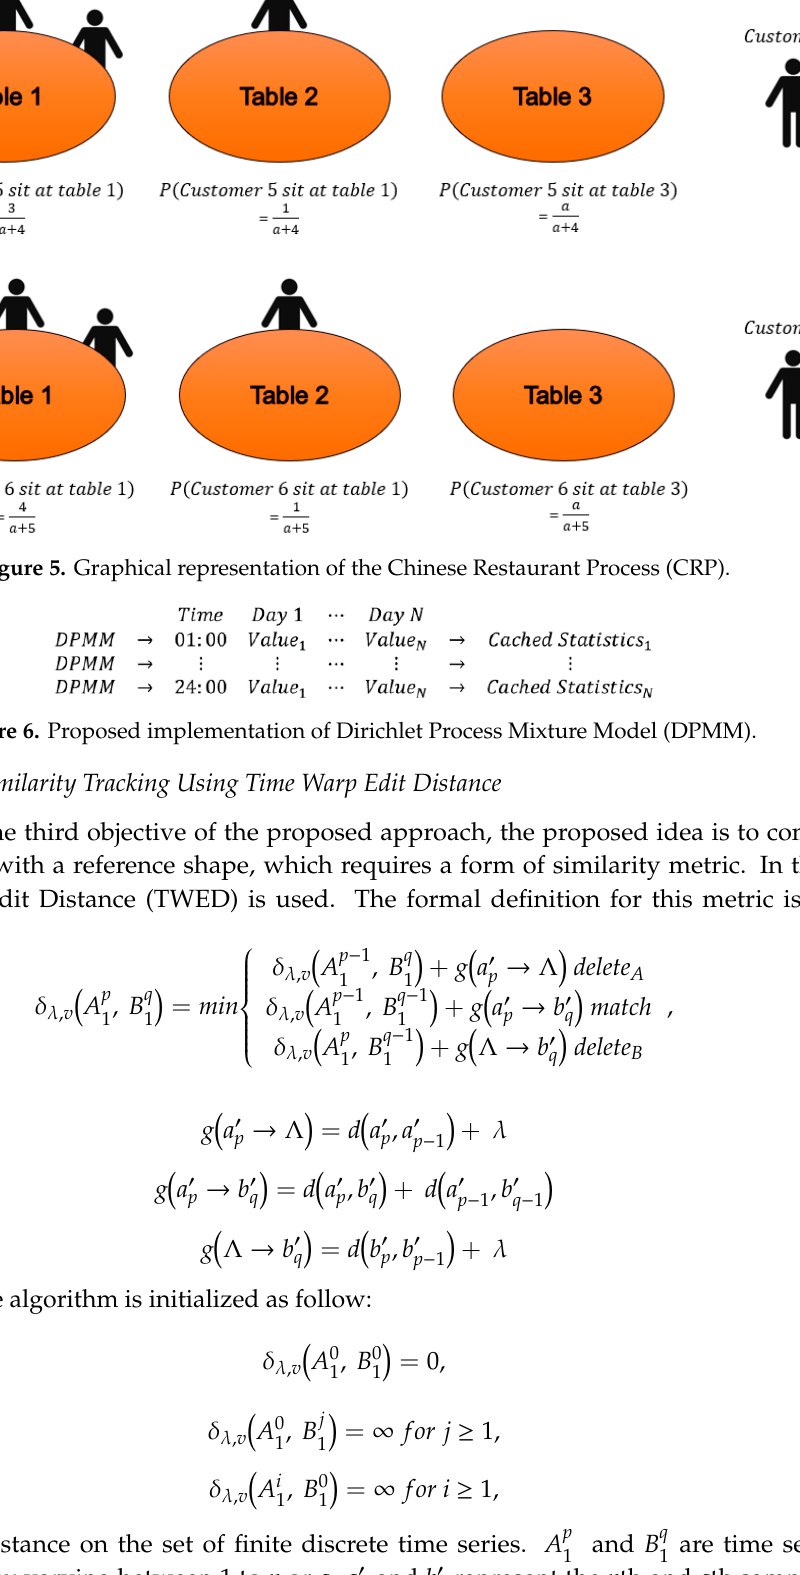
Figure 5. Graphical representation of the Chinese Restaurant Process (CRP).